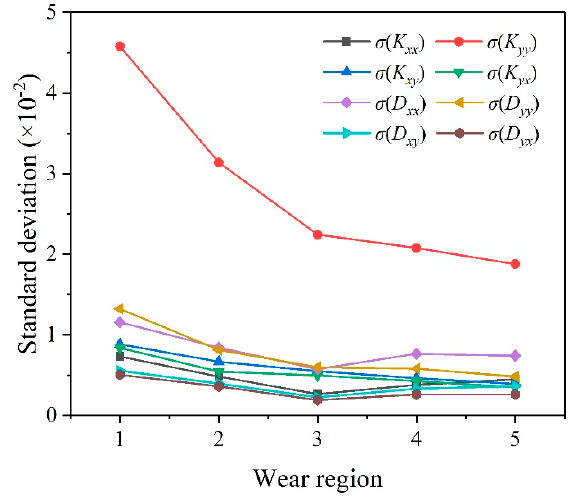
Figure 13. Standard deviation of the eight dynamic coefficients.